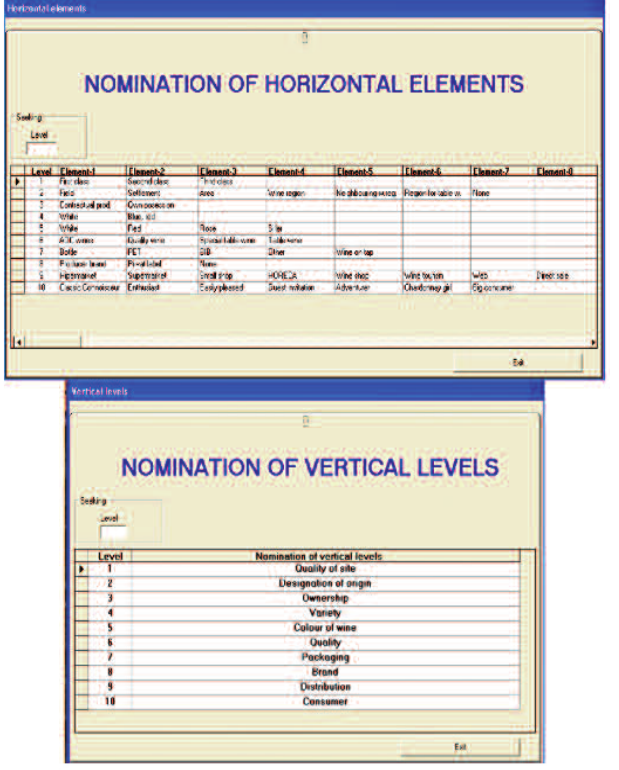
Figure 3. Input of the vertical and horizontal levels in WIN-SIM